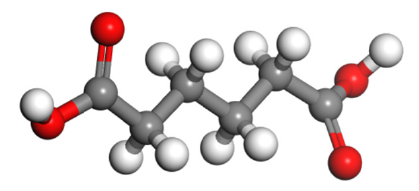
Figure 1. Molecular structure of adipic acid.